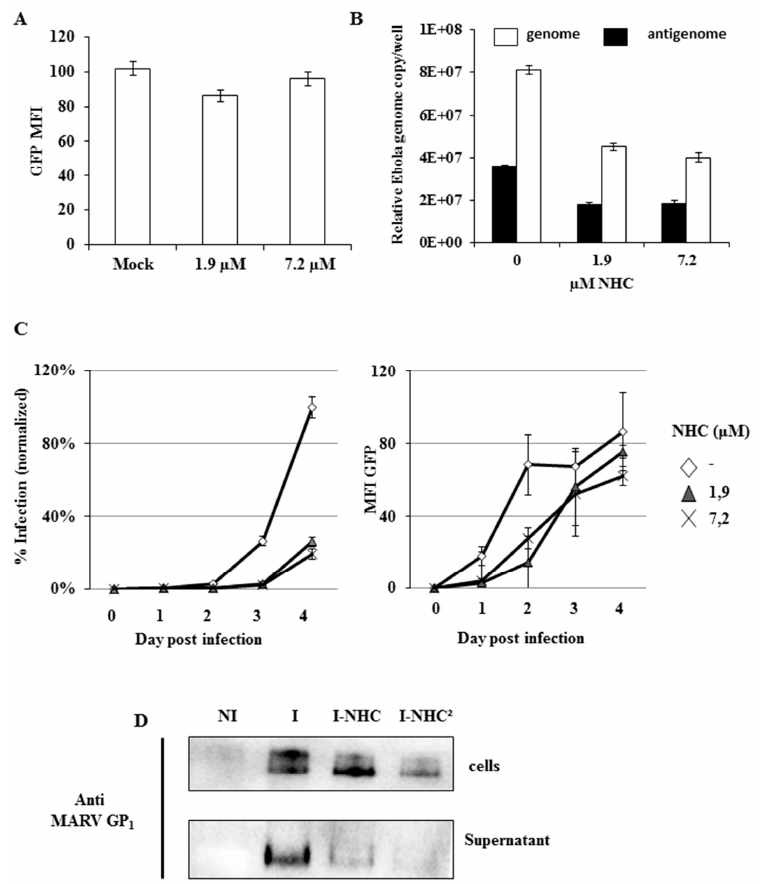
Figure 3. Mode of NHC antiviral activity: ( A ) NHC effect on expression of GFP. Vero E6 cells were transfected with 3 µ g of plasmid DNA expressing GFP (peGFP N1, Clontech) using FugeneHD (Promega), GFP MFI was measured on a Becton Dickinson, LSRII. The graph presents averages and SEM of three independent experiments; ( B ) qRT-PCR analysis of genomic and anti-genomic RNA. Vero E6 cells were infected with EBOV/GFP at an MOI of 0.1 and analyzed 24 h post infection by qRT-PCR. The reverse transcription Iscript select cDNA synthesis (Biorad) was followed by qPCR (Faststart universal Sybr green and LC96 apparatus, both Roche diagnostics) using forward and reverse primer in the non-transcribed trailer region (TR-F: 5’ATTACTGCCGCAATGAATTTAACGC (18429), TR-R: 5’AACAATATGAGCCCAGACCTTTCG (18517)). To distinguish between genomic and antigenomic RNAs, the reverse transcription step was carried out using either a forward or a reverse primer, respectively. The data are representative of the values of two separate experiments performed in duplicate. Data were normalized by using GAPDH Fw and Rev primer (5 1 CACCCACTCCTC CACGTTTGAC and 5 1 GTCCACCACCCTGTTGCTGTAG respectively); ( C ) Inhibition of EBOV replication and spread by NHC. Vero E6 cells were infected with EBOV/GFP at an MOI of 0.01 and were analyzed daily by flow cytometry. Left panel : present of infected cells; right panel : relative GFP fluorescent intensity. The data are representative of the values of two different experiments performed in duplicate. * A student test was performed between value of treated and the Mock treated condition at day 4, p -value below 0.05 for both 1.9 and 7.2 µ M; ( D ) Effect of NHC on Marburg virus replication. Vero E6 cells were infected with Marburg virus (Musoke isolate) at MOI 0.1 and treated with NHC (7.2 µ M) for a period of four days prior to WB analysis. NI, non-Infected cells; I, infected cells; I-NHC, infected cells treated with NHC at day 0; I-NHC 2 , infected cells treated with NHC twice. Second treatment was performed at day 2 after cell washing and media replenishment. Western blot analysis of cells and culture supernatants was made using a mouse anti-Marburg GP1 antibody (clone 6589). The data are representative of the values of two different experiments.